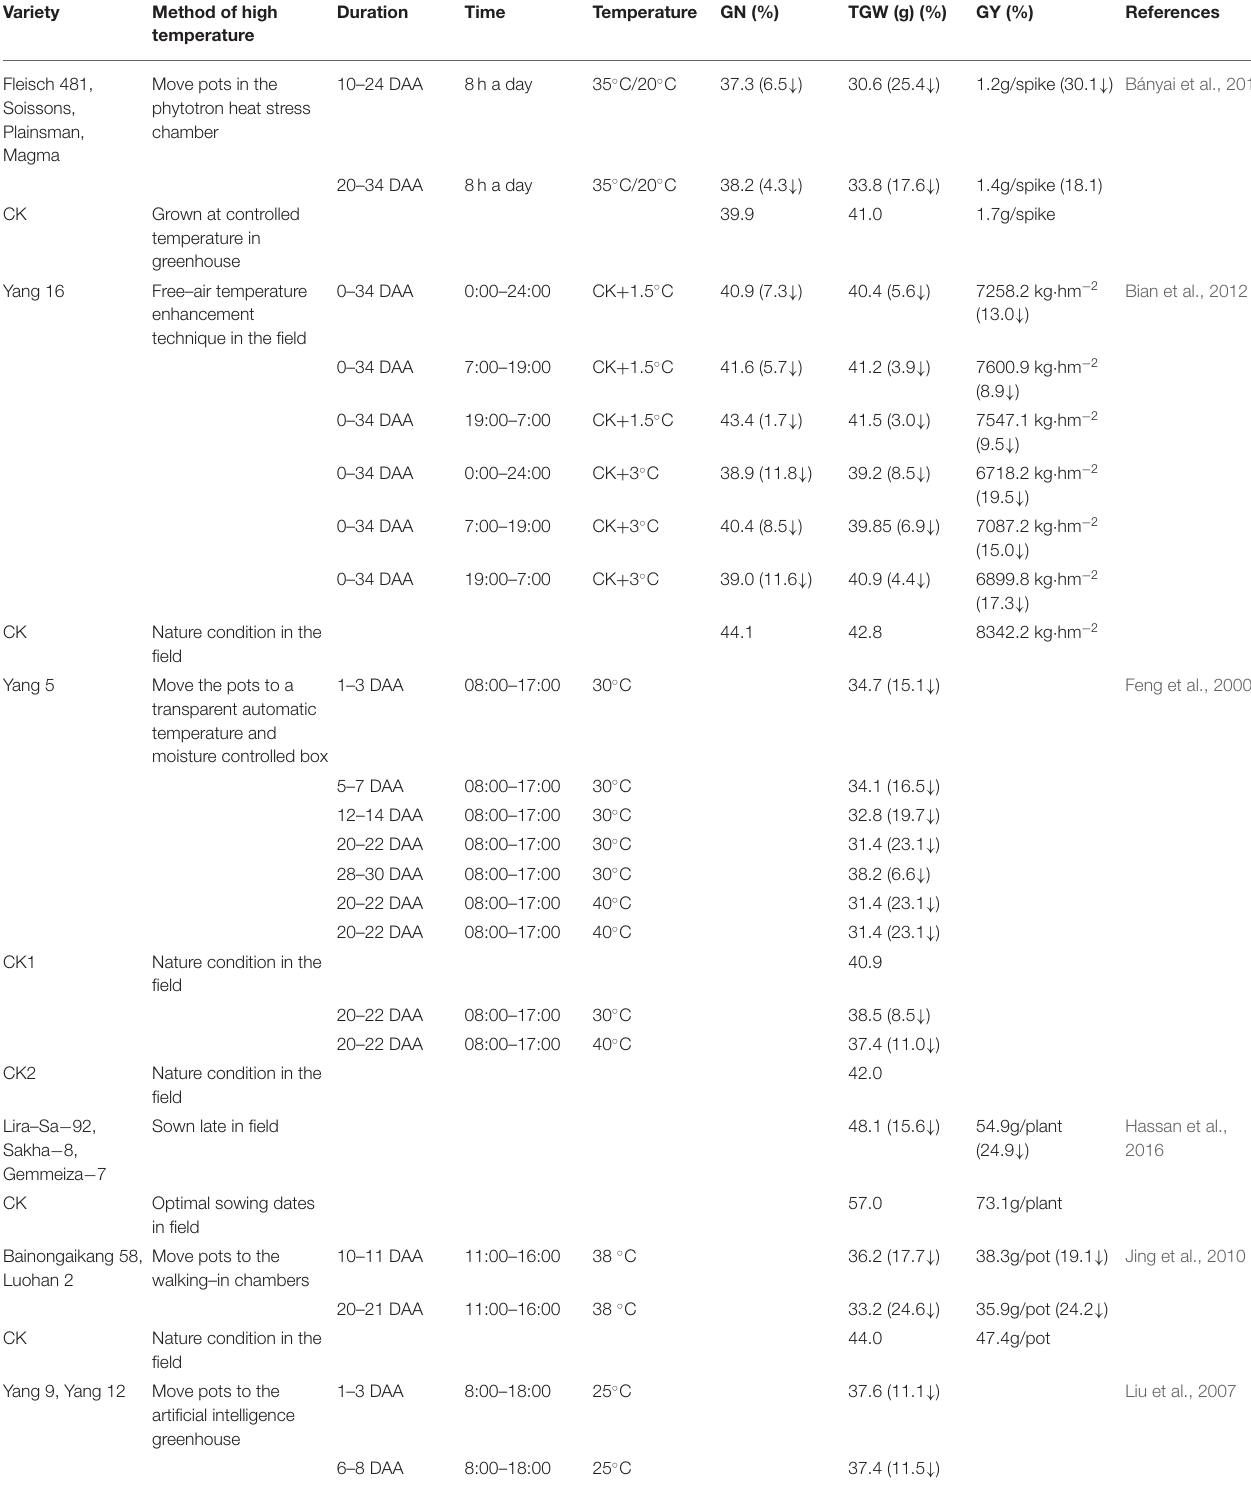
TABLE 1 | Effect of high-temperature treatment at different days after anthesis (DAA) on grain number (GN), 1,000-grain weight (TGW) and grain yield (GY) in wheat. Variety Method of high